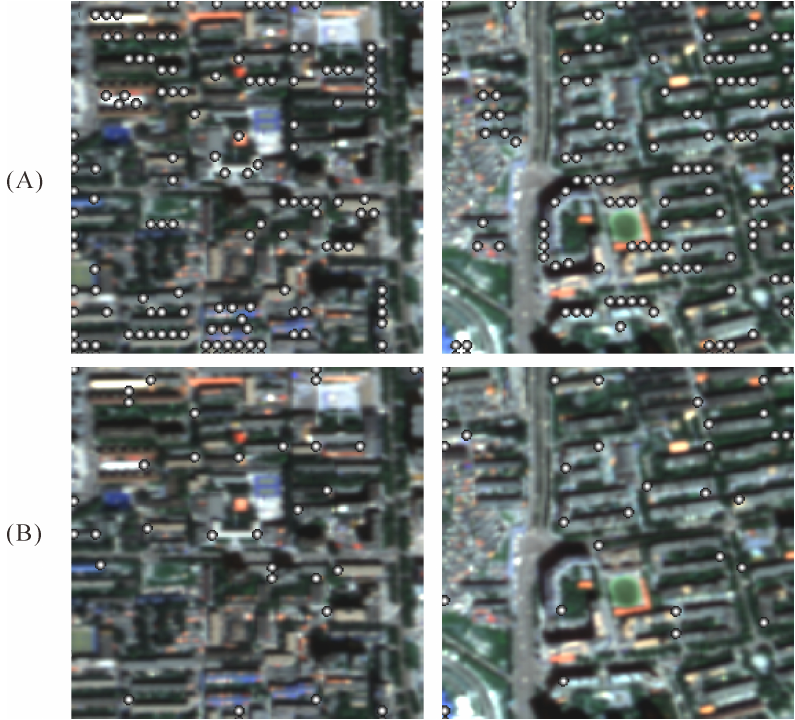
Figure 16. Visualization of the locations of sampled points. ( A ) Edge points. ( B ) Corner